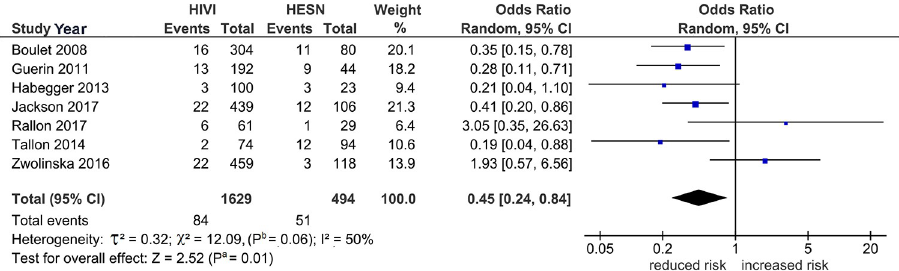
Fig 2. Pre-outlier (PRO) summary effects of 3DS1S1 on HIV acquisition in Caucasians. Diamond denotes the pooled odds ratio (OR) indicating reduced risk (OR 0.45). Squares show the OR of each study. Horizontal lines on either side of each square represent 95% confidence intervals (CIs). Significance from the Z test for overall effect is moderate (P a = 0.01). The χ 2 test shows the presence of heterogeneity (P b = 0.06, I 2 = 50%); I 2 : a measure of variability expressed in